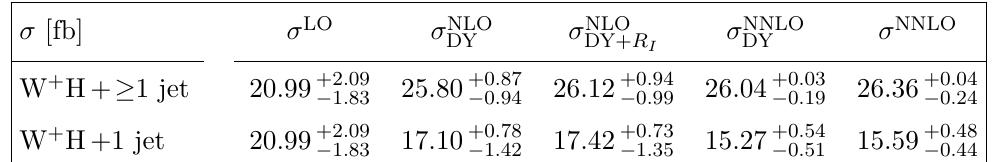
Table 1. The fiducial cross sections for inclusive ( ≥ 1 jet) (top line) and exclusive (1 jet) (bottom line) associated to W + H + jet process according to the setup of section 3 and the cross section expressions and labelling as defined in section 2.3. The theory error on the values represents the minimum and maximum from the 7-point scale variation. See main text for details.